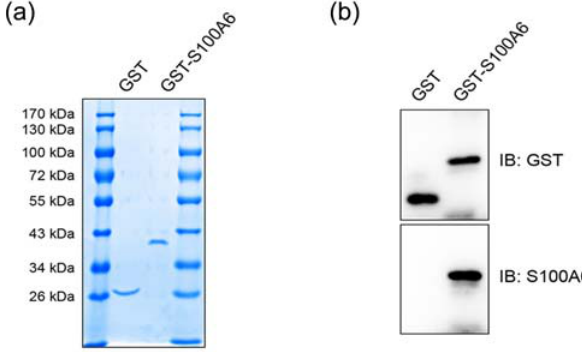
Figure 2: Identi fi cation of human GST - S100A6 by Coomassie blue staining and immunoblotting analysis. ( a ) Detection of recombinant proteins human GST - S100A6 and GST by Coomassie blue staining: GST - S100A6 is approximately 37 kDa and GST is approximately 26 kDa. ( b ) Detection of recombinant proteins human GST - S100A6 and GST by immunoblotting